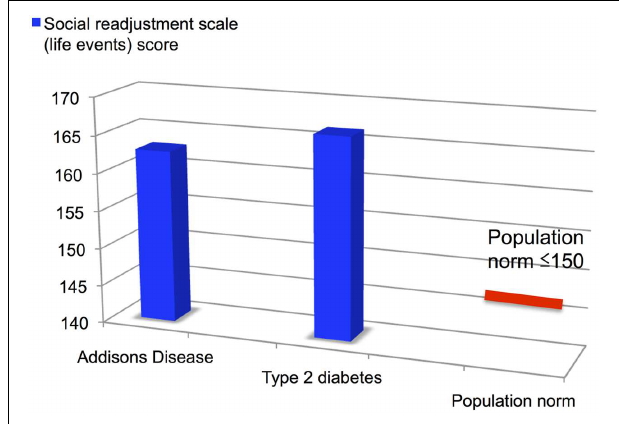
Type 2 diabetes (Mean/SD) group (Mean/ SD